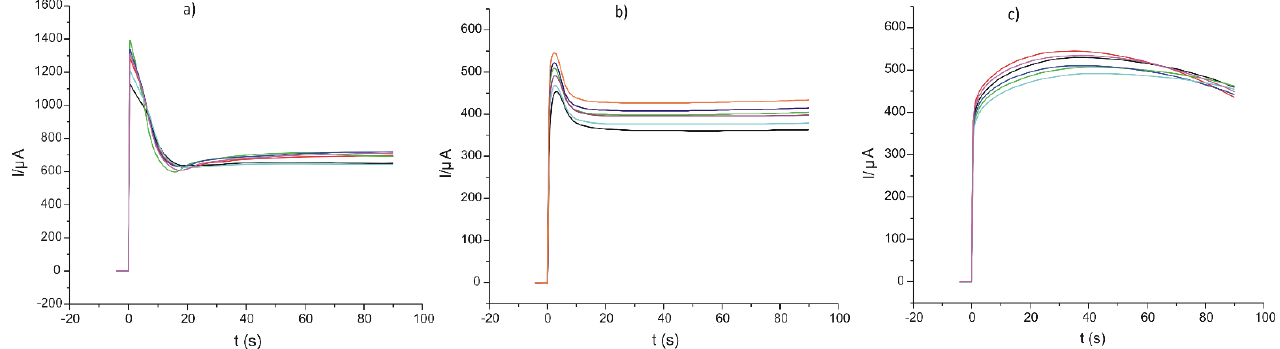
Figure 2. Current versus time curves registered during the electrosynthesis of six different sensors prepared in the same conditions ( a ) PPy /FeCN, ( b ) PPy/NP, and ( c ) PPy/SDS.